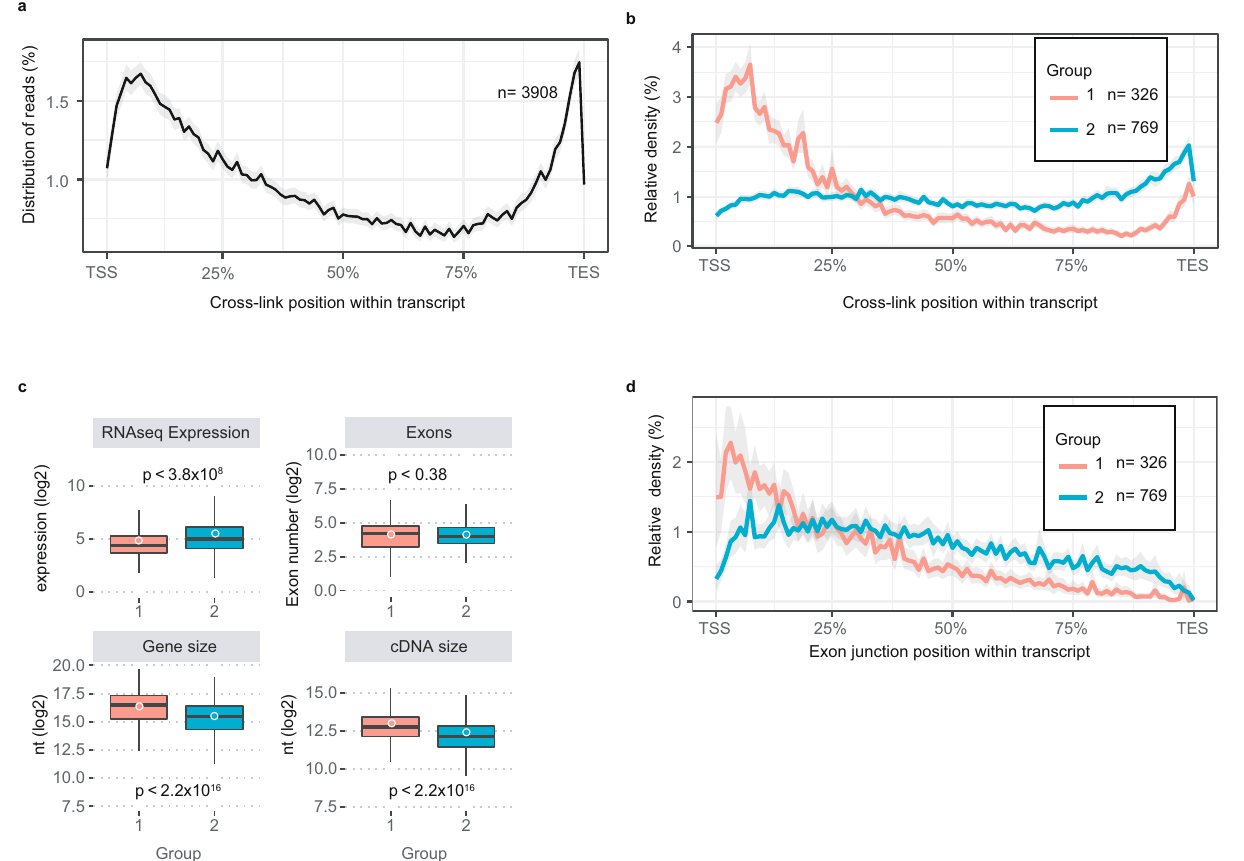
expression values, total exons, gene size and cDNA size of the two gene groups from b .Shownvalueswerelog2transformed.Atwo-sidedWilcoxranksumtestwas used tocomparethemeans.Noadjustmentsweremadeformultiplecomparisons. p values are shown on respective panels. Group 1 n =326 genes assessed over two biological replicates; Group 2 n =769 genes assessed over 2 biological replicates. d Asin b butplottingtheaverageinternalexon-junctiondensitiesacrossgroup1or 2 TUs. Source data are provided as a Source Data fi